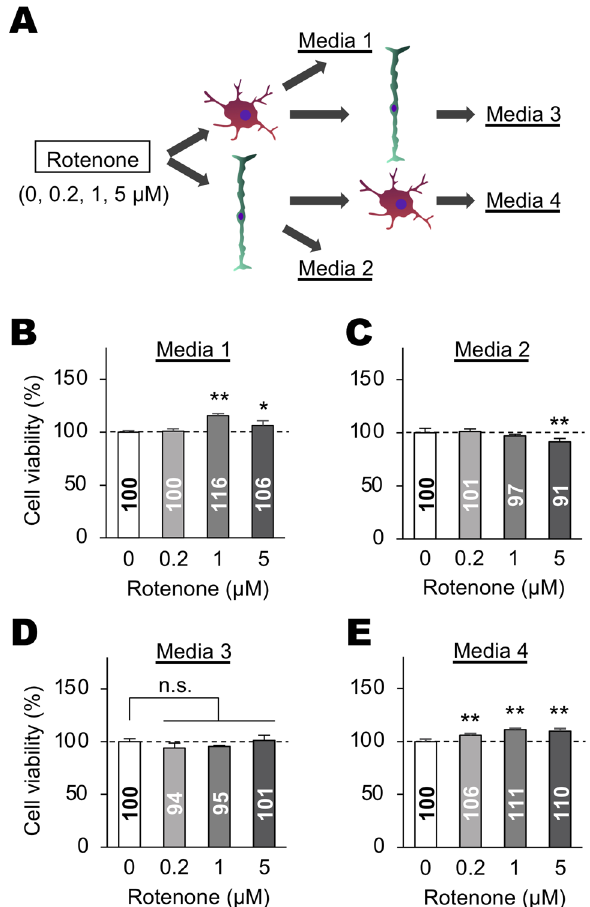
Figure 4. Effects of conditioned media of rotenone-treated Müller and BV-2 cells on survival of dissociated retinal cells. ( A ) Schematic for the preparation of conditioned media of rotenone-treated Müller and BV-2 cells. BV-2 and Müller cells were treated with various concentrations of rotenone for 24 h and were then cultured with fresh media for 24 h more. The conditioned media of BV-2 and Müller cells were collected (Media 1 and 2, respectively). Naïve Müller and BV-2 cells were cultured with Media 1 and 2 for 24 h and were then collected (Media 3 and 4, respectively). ( B – E ) Cell viability assay on mouse dissociated retinal cells cultured with Media 1–4 for 24 h, respectively. Viability was shown as values relative to that of rotenone (−) control. Error bars indicate standard deviation. * P < 0.05 and ** P < 0.01 versus rotenone (−) control (Dunnett’s test; n = 4). n.s.: not